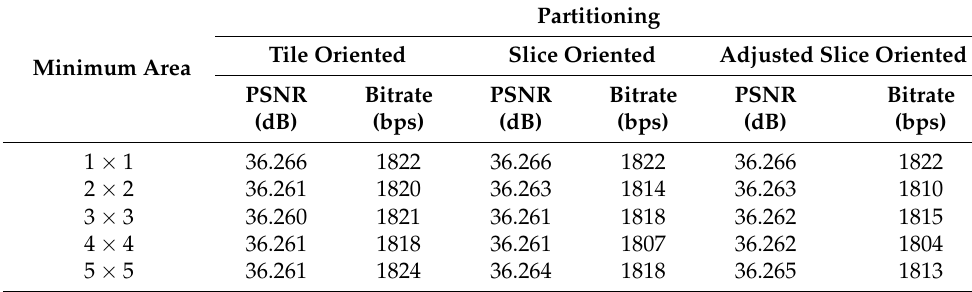
Table 3. PSNR (dB) and bitrate (bps) for different values of minimum area.